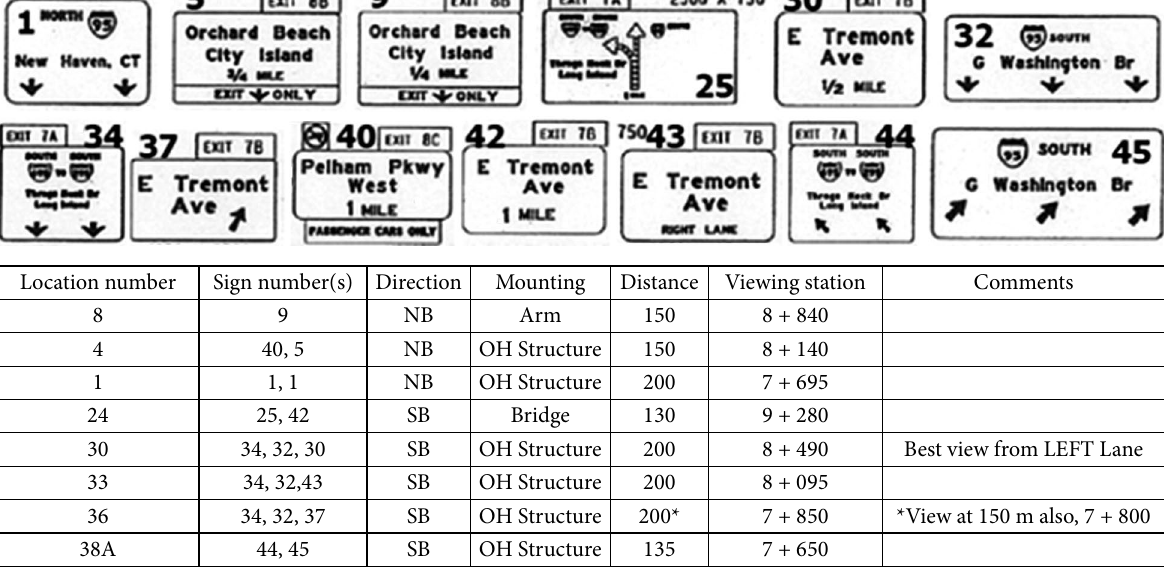
Fig. 1. Guide signs and locations selected for the initial field measurement sample. Also shown are the viewing distance(s) and mounting type for each sign. Multiple sign numbers appear at different locations when duplicate sign panels appeared before a highway